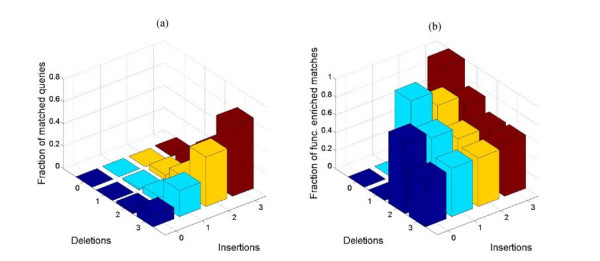
Properties of matched pathways in different indel categories. (a) The fraction of yeast queries with identifiable matching fly pathway out of all yeast queries within different indel categories. (b) The fraction of matched fly pathways that are functionally enriched out of all matched fly pathways in each indel category. Indel categories not covered by any matched pathway were marked as having 0% functionally enriched pathways.